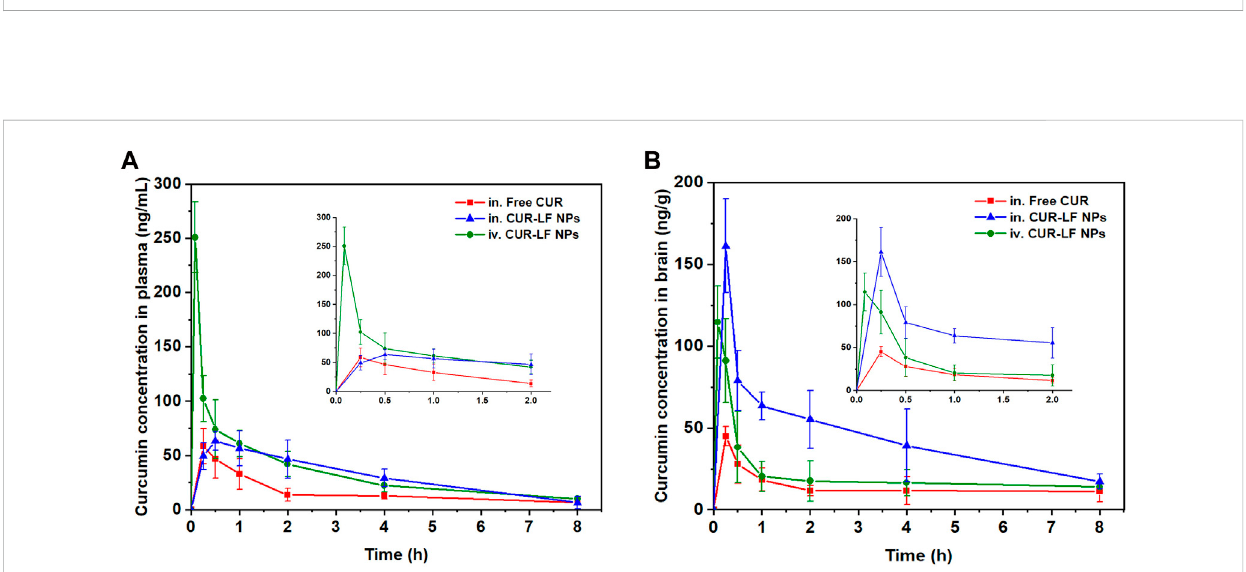
Concentration-time pro fi les of curcumin up to 8 h post-dosing in (A) plasma, (B) brain following intranasal administration of curcumin suspension and CUR-LF NPs, and intravenous injection administration of CUR-LF NPs at a dose of 10 mg/kg. Data were presented as mean ± SD (n = 3).